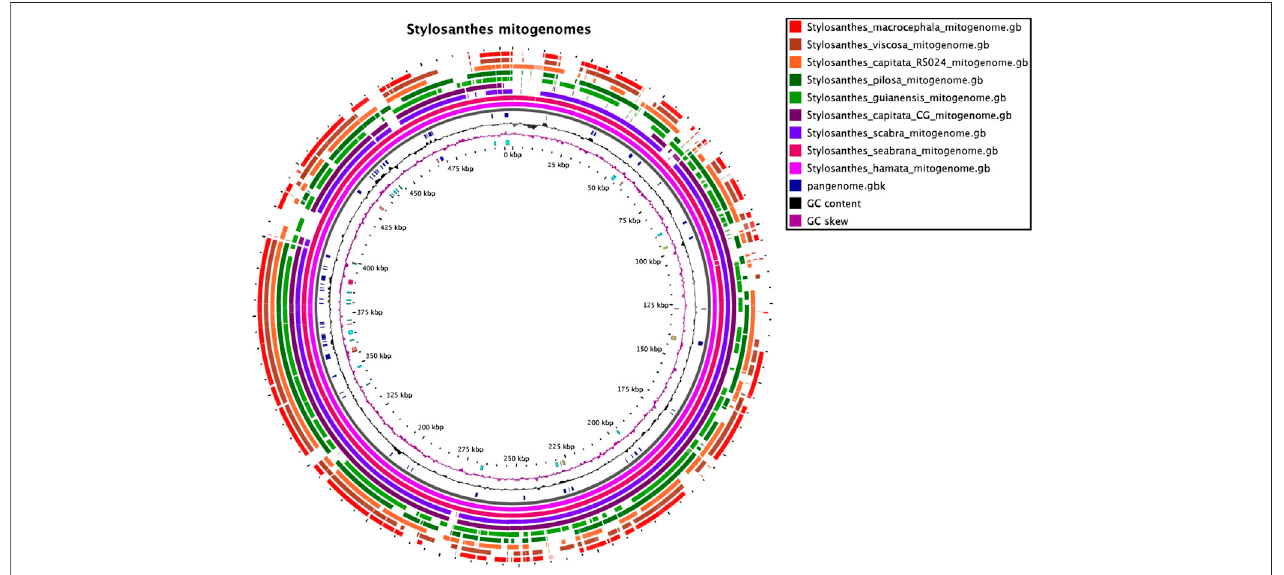
FIGURE 1 | The mitochondrial pangenome of Stylosanthes . Annotated sequences and features are shown in the inner circle. For details see Supplementary Figure S1 , Supplementary Tables S1, S2 .